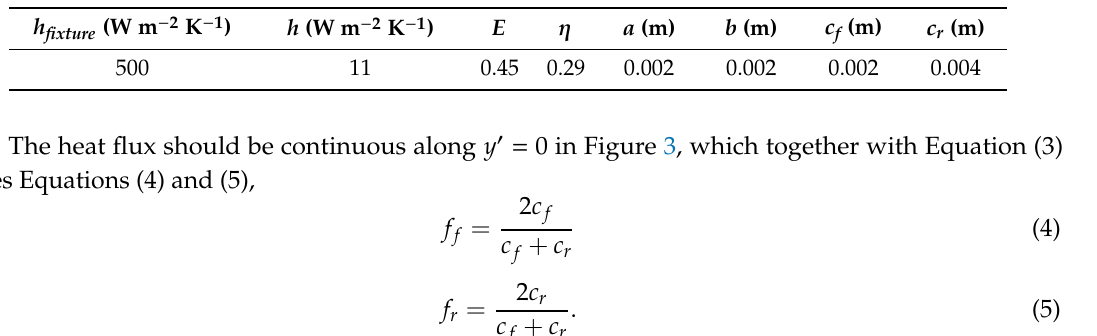
Table 3. Calibrated and given